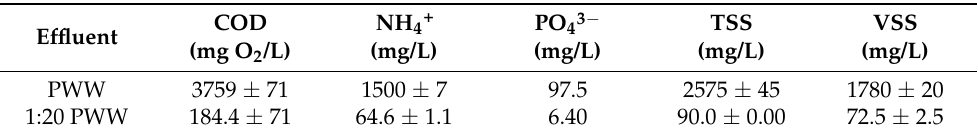
Table 1. Composition of the piggery wastewater (PWW) and diluted 1:20, in terms of chemical oxygen demand (COD), ammonia nitrogen (NH 4+ ), phosphate (PO 43 − ), total suspended solids (TSS), and volatile suspended solids (VSS)